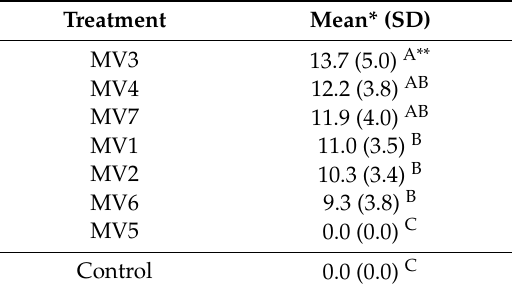
Table 2. Means (standard deviation–SD) of microtensile bond strength and Tukey HSD results for primer irrespective of aging